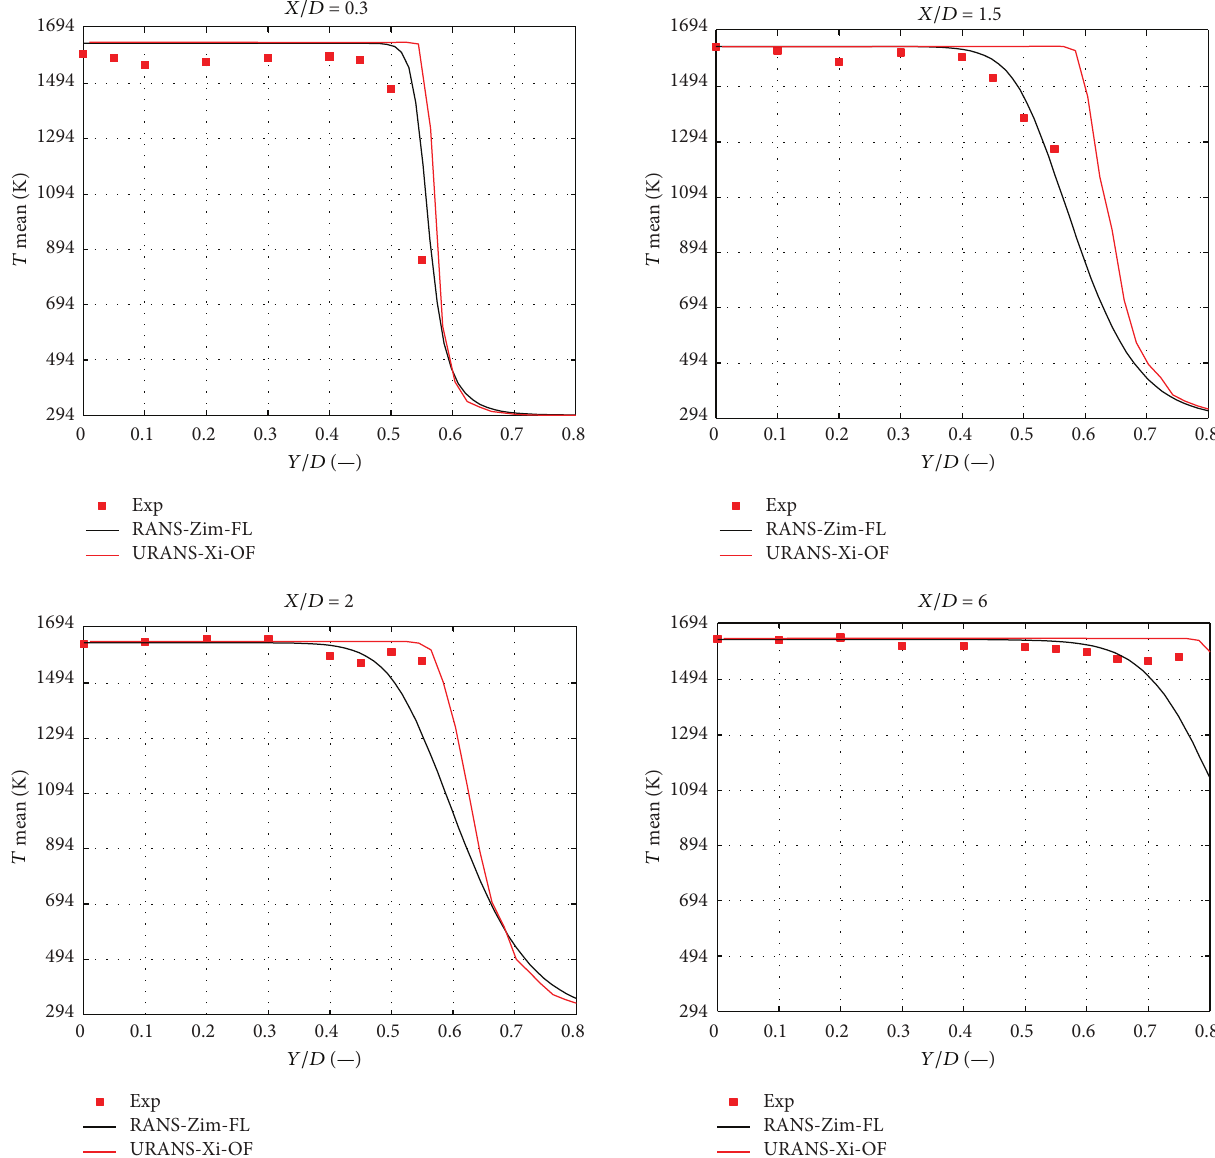
Figure 13: Mean temperature profiles with OpenFOAM